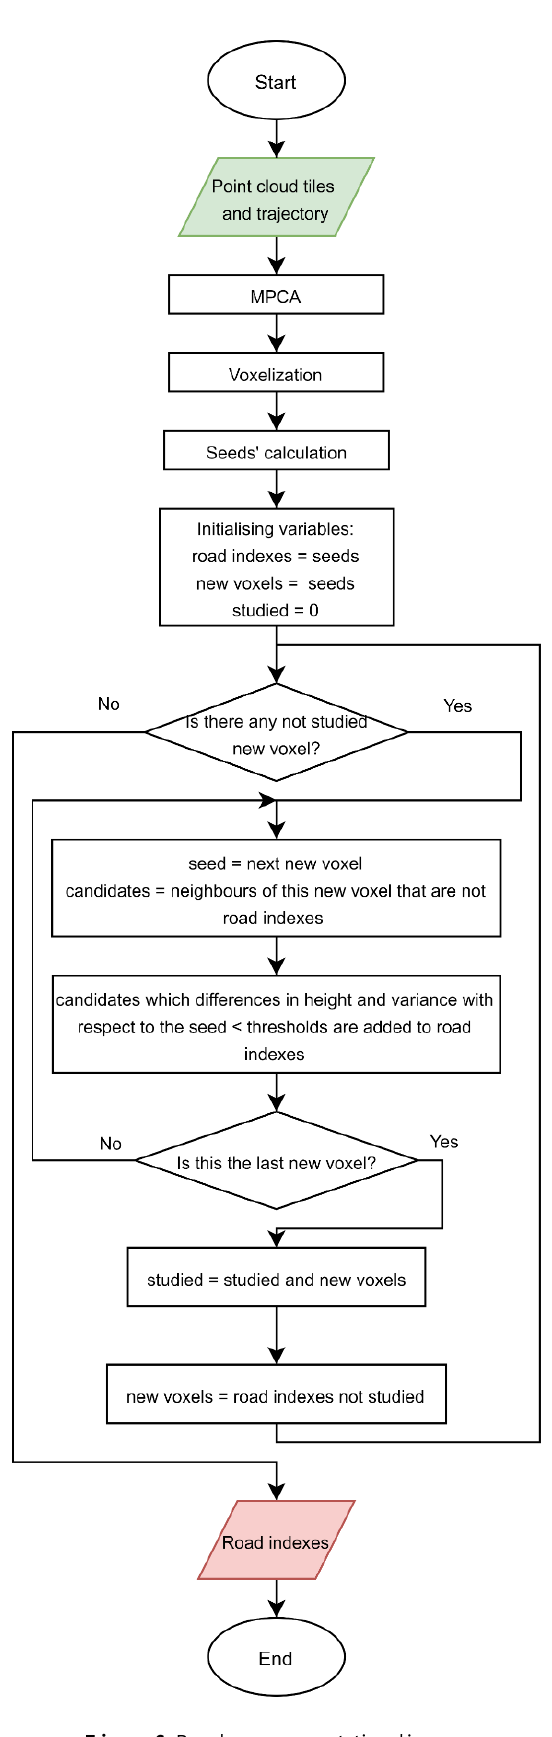
Figure 6. Roadway segmentation diagram.